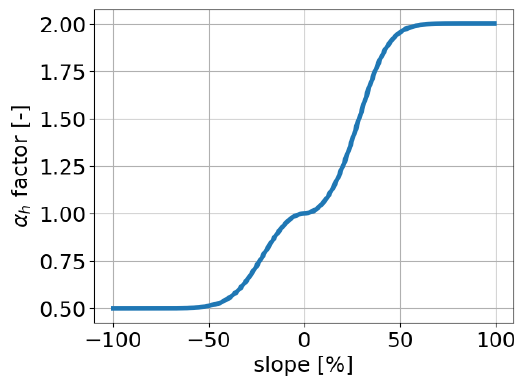
Figure 6. Topographic influencing factor α h .